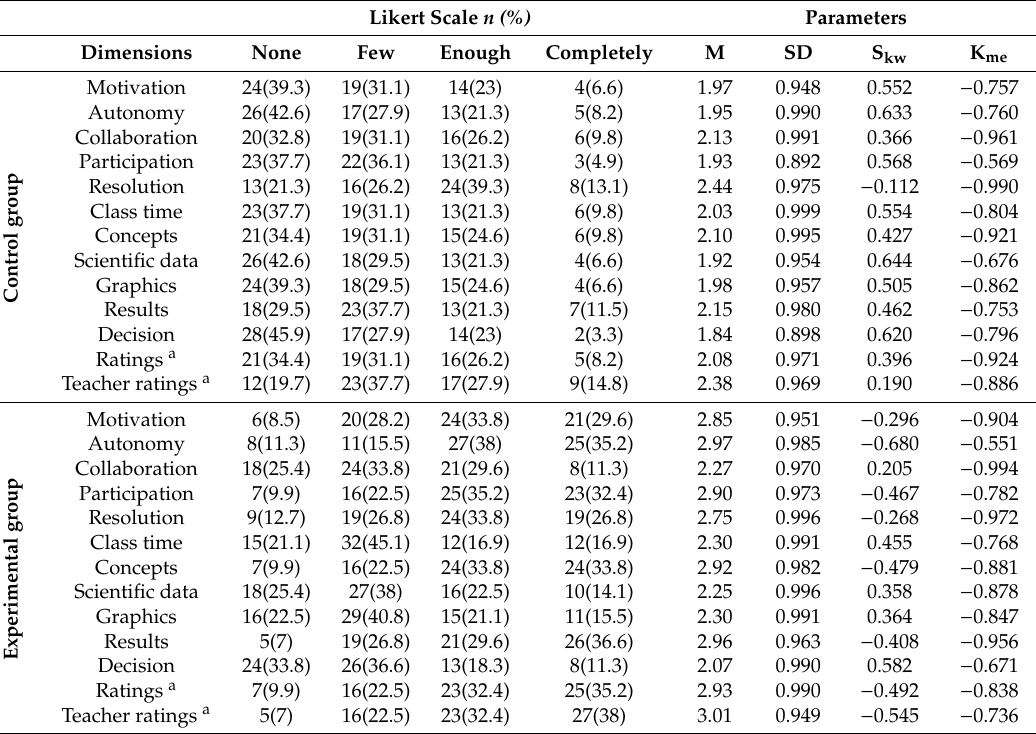
Table 2. Results obtained for the dimensions of study in GC and EG of high school